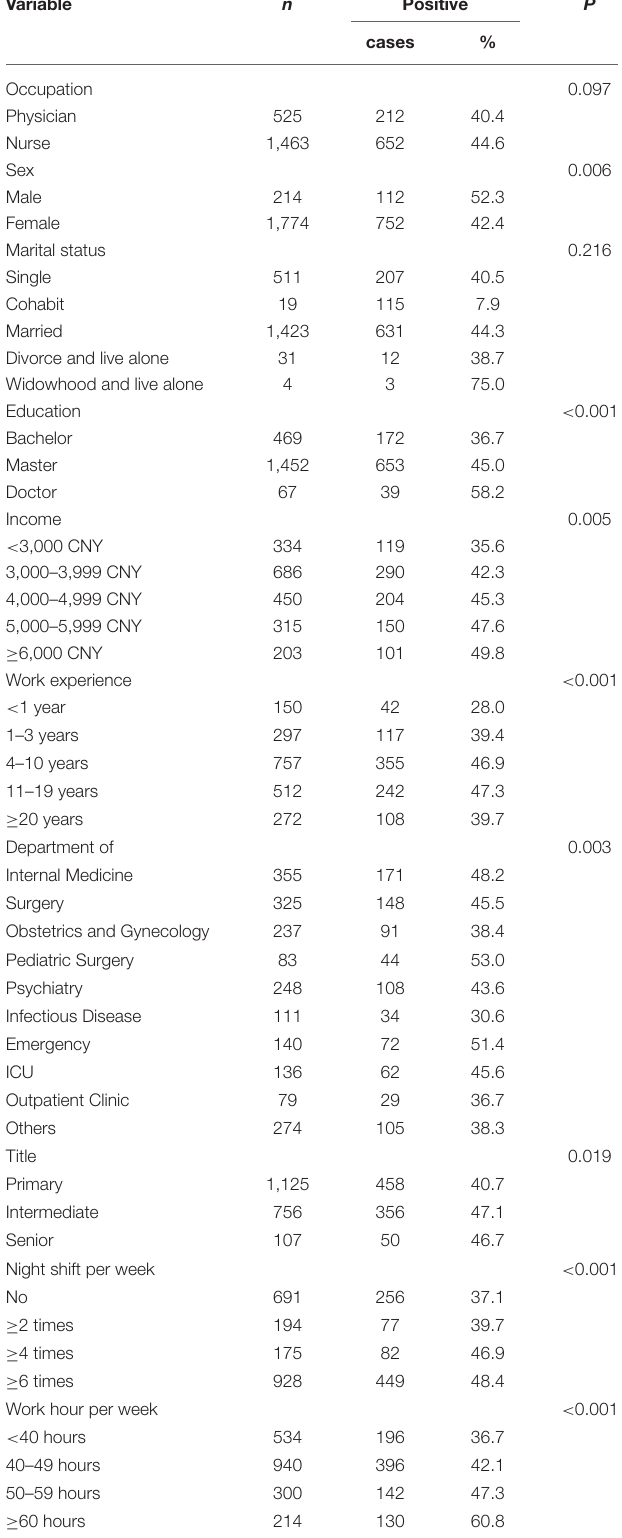
TABLE 1 | Demographic and occupational characteristics of participants ( n = 1988) and comparisons on the positive case of depression symptoms.